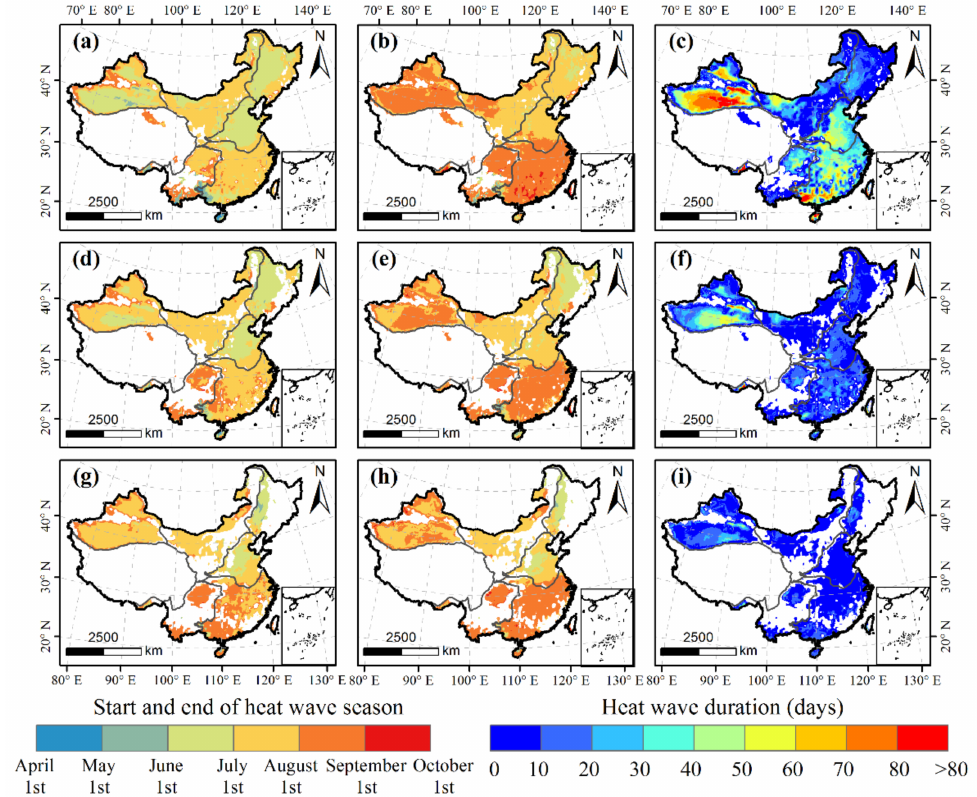
Figure 8. Average heatwave onset, termination, and duration at different levels for years from 1979 to 2018. First ( a , d , g ), second ( b , e , h ), and third ( c , f , i ) columns are the onset, termination, and duration, respectively. First ( a – c ), second ( d – f ), and third ( g – i ) rows are light heatwave, moderate heatwave, and severe heatwave,